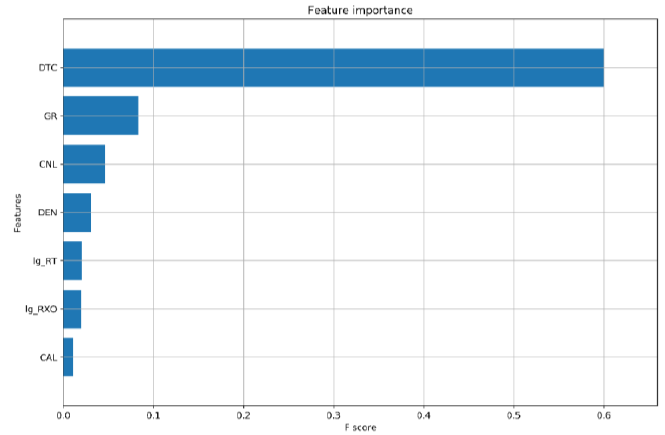
Figure 8. Bar graph for ranking the importance of the feature curve.